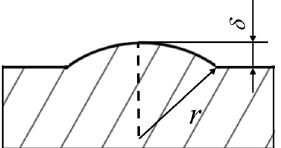
Table 1. Protrusion structure size of each surface.